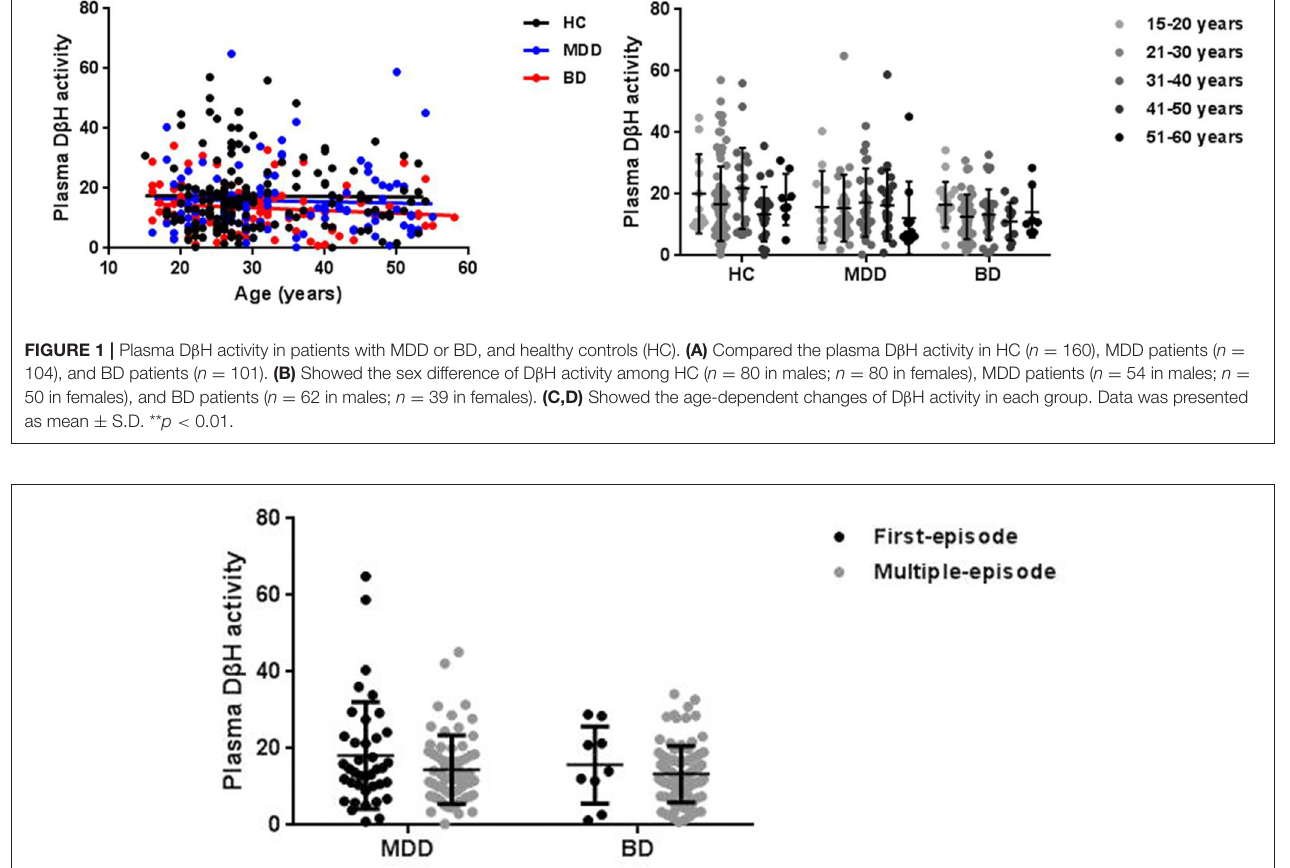
FIGURE 2 | Plasma D β H activity in patients with different episodes, including first-episode (FE) and multi-episode (ME) in MDD and BD. There was no significant difference in D β H activity in patients with different episodes in neither MDD ( n = 40 in FE; n = 64 in ME) nor BD ( n = 10 in FE; n = 91 in ME) groups. Data was presented as mean ±